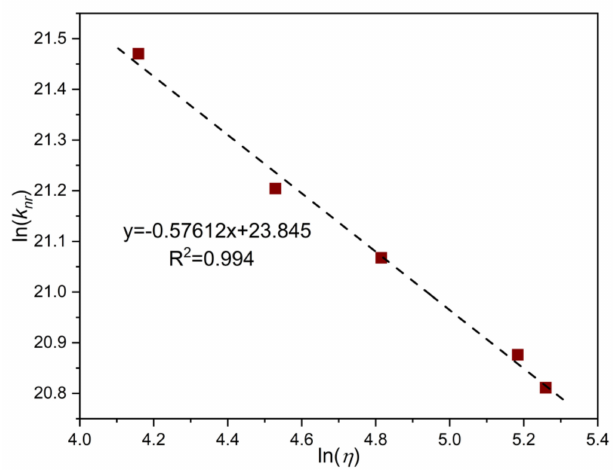
Figure 6. Ln-ln plot of the rate coe ffi cients of the non-radiative decay of PhSt in PEG solutions vs. solvent